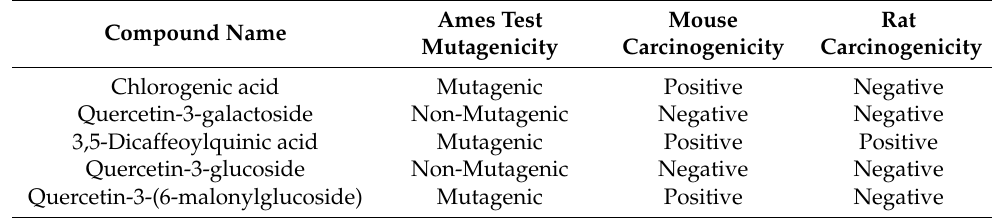
Table 3. Toxicity prediction of the main components present in the C. olitorius